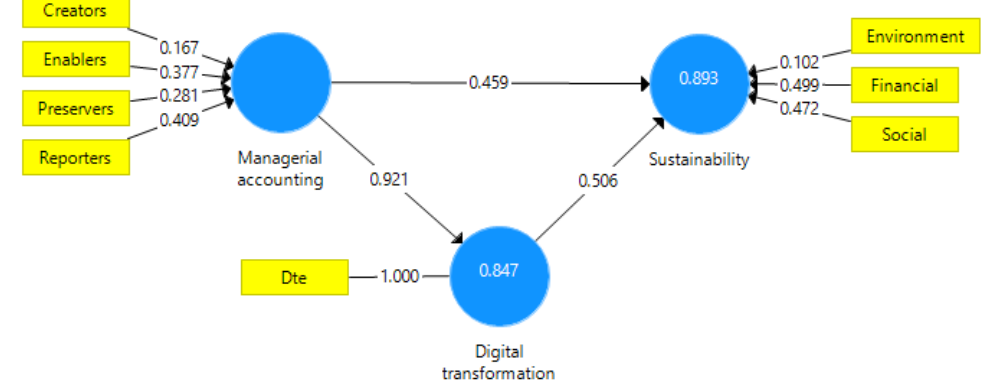
Figure 5. Applied model. Source: the authors’ own design using SmartPLS v3.0.